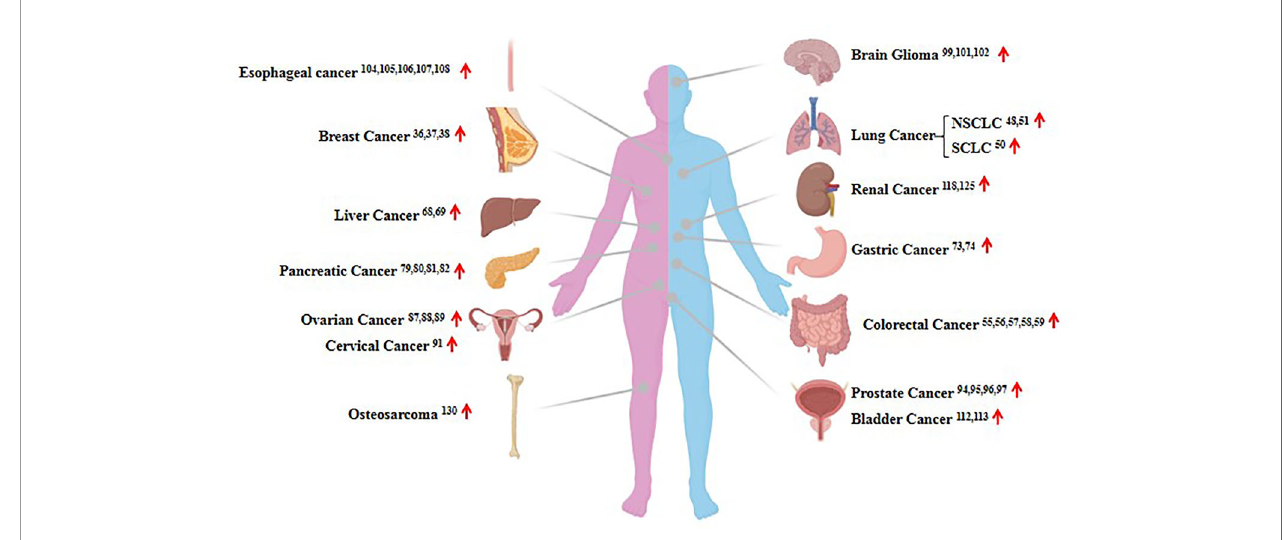
FIGURE 3 | TheexpressionofHOTAIRinhumancancers.Shownareexamplesoftheorgan-speci fi